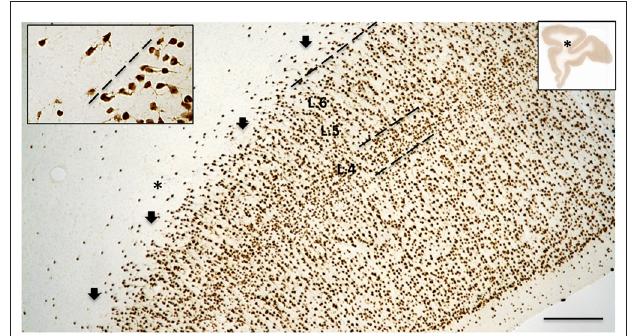
FIGURE 2 | The border between layer 6 (L. 6) and the superficial WM is typically broken or scalloped, with cell-sparse gaps (arrows), as seen in this coronal section from the upper bank of the principals sulcus (asterisk in the low magnification section, inset at right; from case 189). Dashed line indicates border between L. 6 and the superficial WM. The borders of layer 4 (L. 4) are also indicated. Higher magnification inset at upper left illustrates lower density of neurons in the WM, as compared with L. 6, as well as their tendency for more horizontal orientation. Scale bar = 300 µ m for the large-field and 75 µ m for inset.